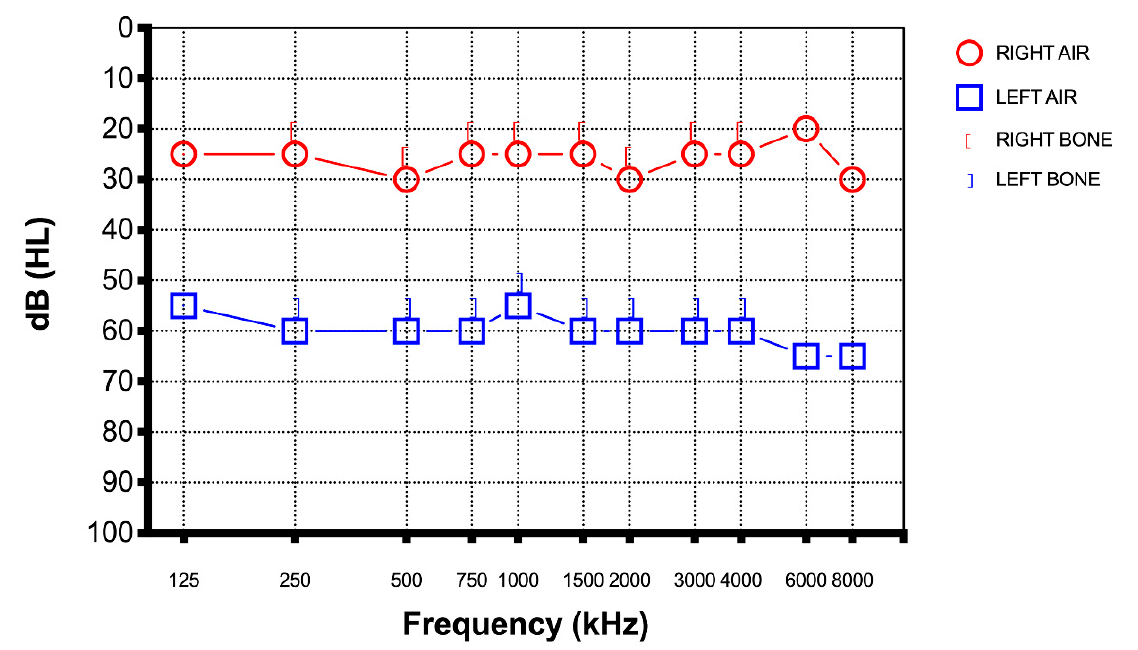
Figure 2. Case 2: pure tone audiometry seven days after the third dose of the Moderna COVID-19 vaccine showed profound right SSHL at least 60 dB in every frequency.